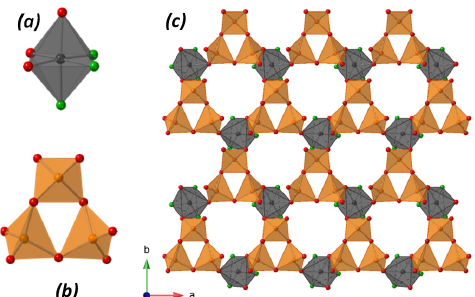
Figure 2. Illustration of ( a ) GeO 3 F 3 octahedra, ( b ) Ge 3 O 9 unit, and ( c ) their connectivity to form the germanium oxyfluoride layer. Germanium octahedra are shown in grey, germanium tetrahedra in orange, oxygen in red, and fluorine in green.